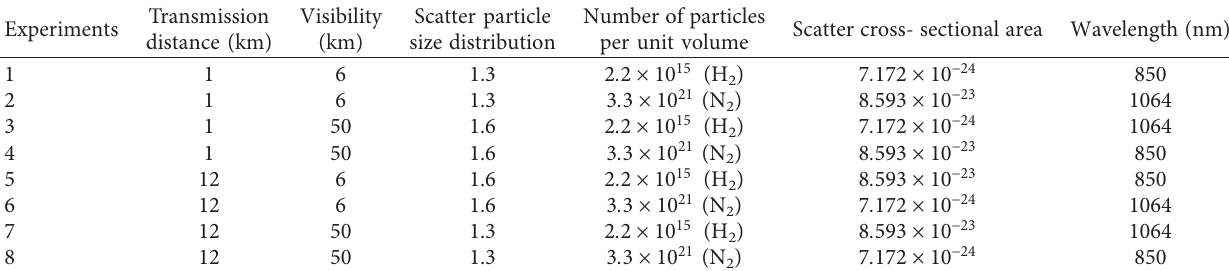
Table 8: Results using Taguchi